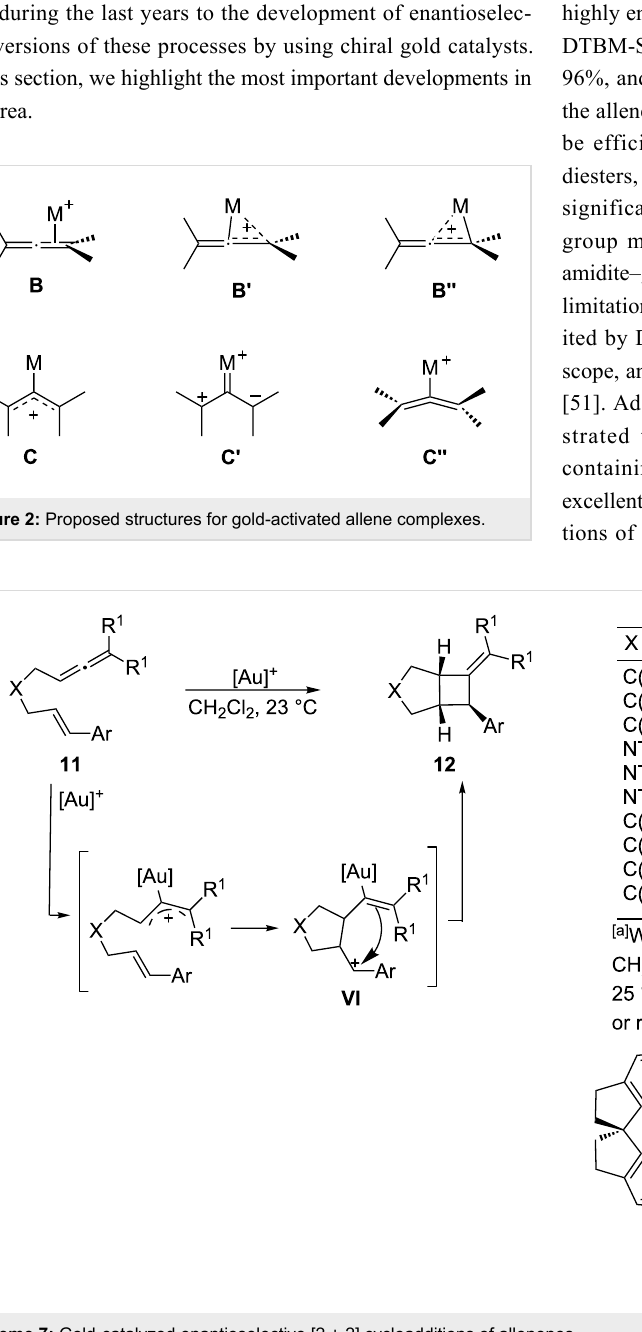
Scheme 7: Gold-catalyzed enantioselective [2 + 2] cycloadditions of allenenes.